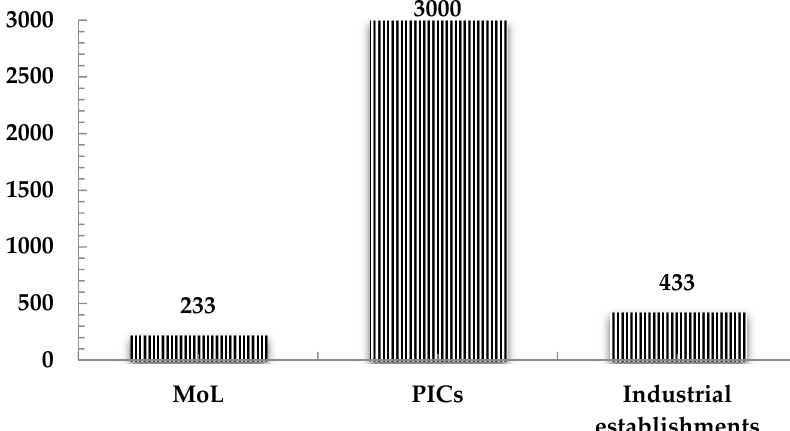
Figure 2. The number of occupational accidents (O.A) according to the Ministry of Labor (MoL) and Palestinian insurance companies (PICs) (2016–2017) reports [35–40], and those obtained from the industrial establishments during this research’s survey.